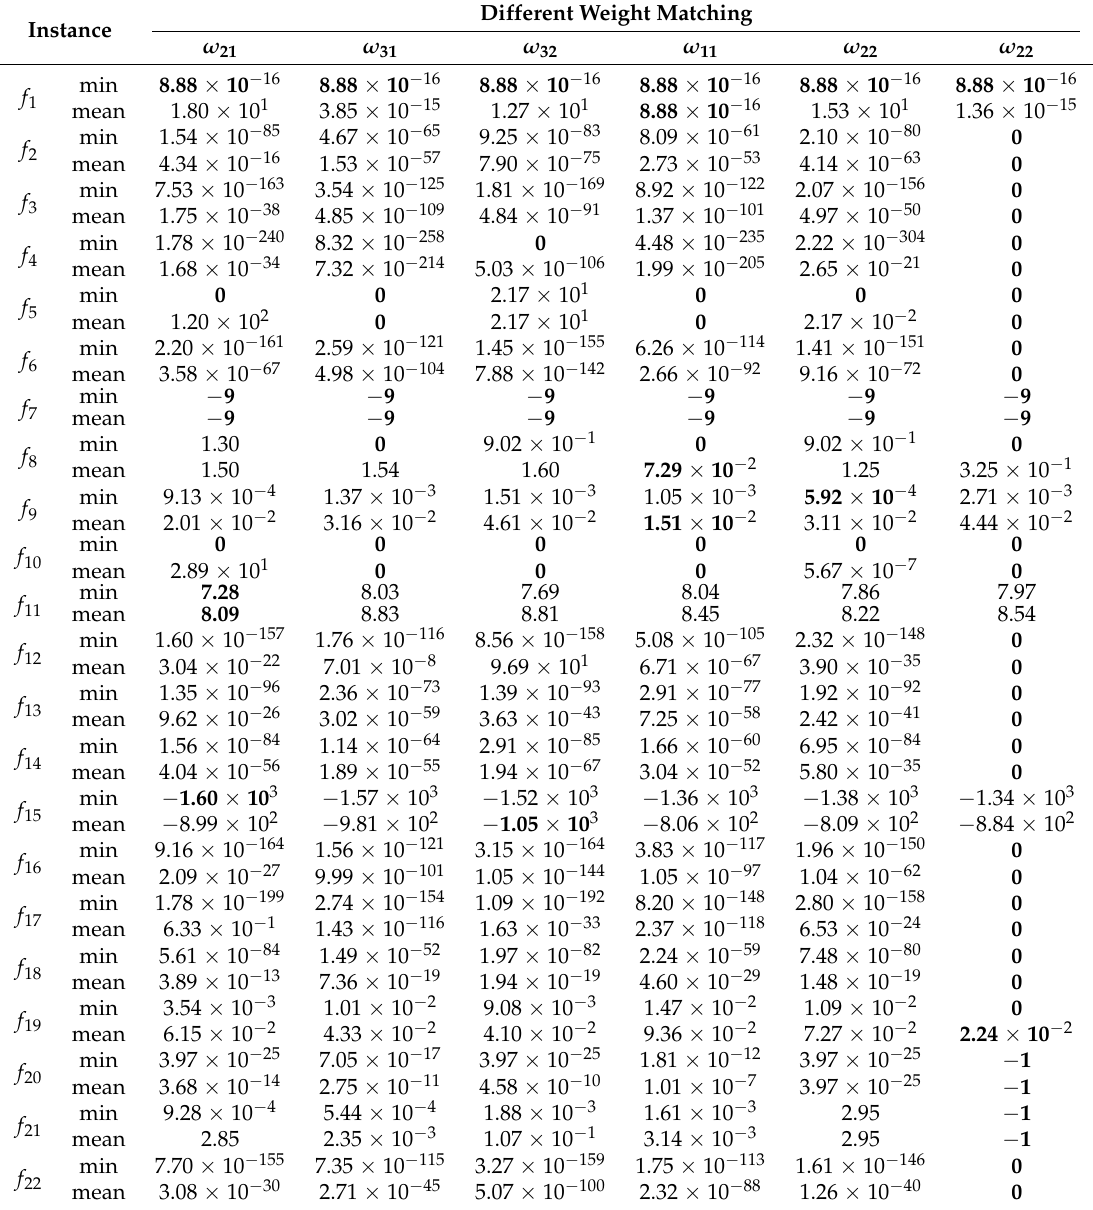
Table 5. Discussion on the weights selection of